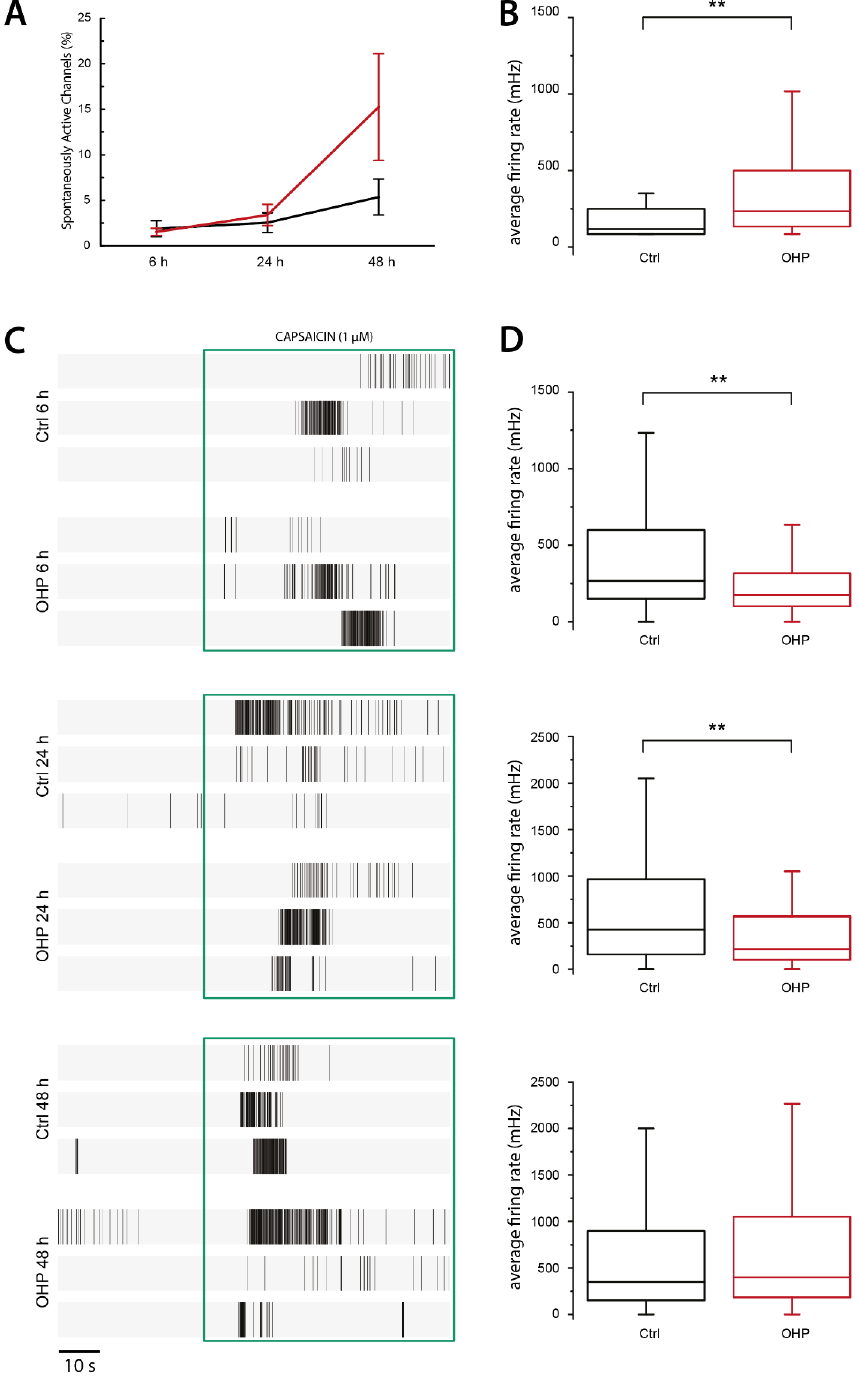
Figure 4. Effects of OHP treatment on spontaneous and evoked electrical activity in DRG neurons. ( A ) Trend of the percentage of basally active channels in control (black) and treated (red) conditions (mean ± SEM of n MEAs, with n ranging from 4 to 10). Data were analyzed through a linear regression of the log-transformed values, then the null hypothesis of zero-slope was tested. The percentage of spontaneously firing DRG neurons showed a positive trend in time when treated with OHP ( p -value = 0.009) but not in control condition. ( B ) After 42 h from the treatment with OHP, the median firing rate per active channel resulted significantly higher (M 0,OHP = 233 mHz, IQR 0,OHP = [133; 500] mHz) compared to untreated condition (M 0,ctrl = 117 mHz, IQR 0,ctrl = [83; 250] mHz; ** p -value = 0.002, Mann–Whitney U test). ( C ) Three representative raster plots for each tested condition showing